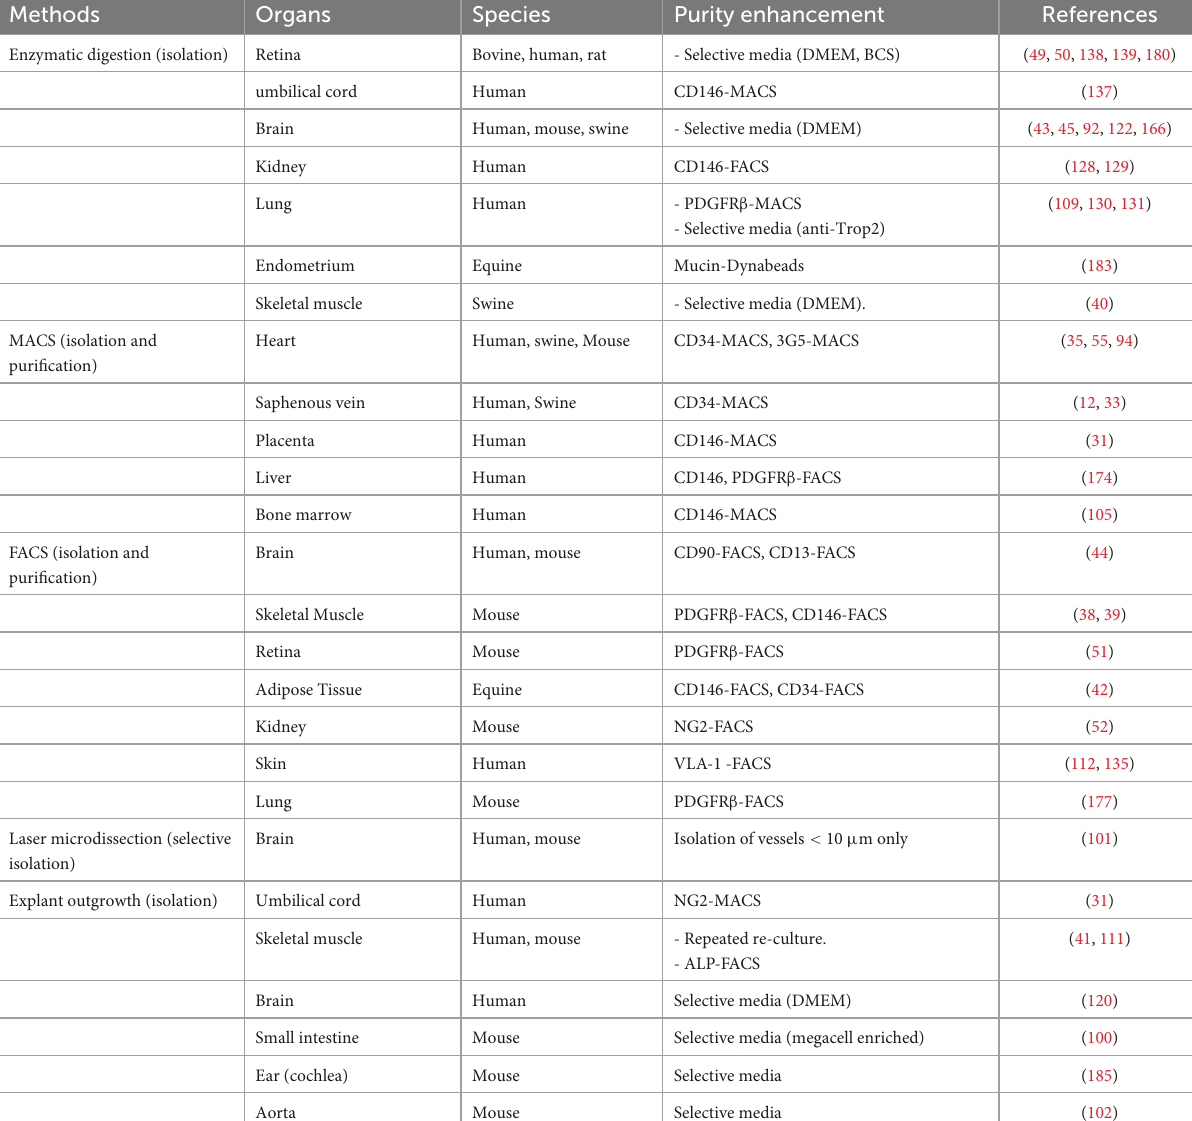
TABLE 2 Different strategies and methods for enhancing purity in isolation and purification of pericytes from different species and tissues.